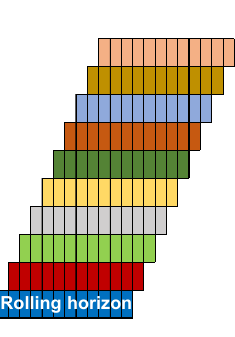
Figure 2. Rolling horizon approach.